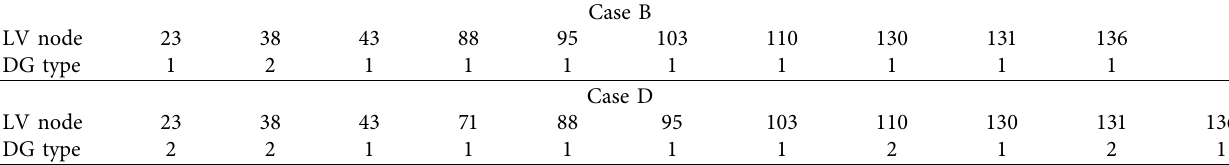
Table 5: Locations and types of DG installed for Cases B and